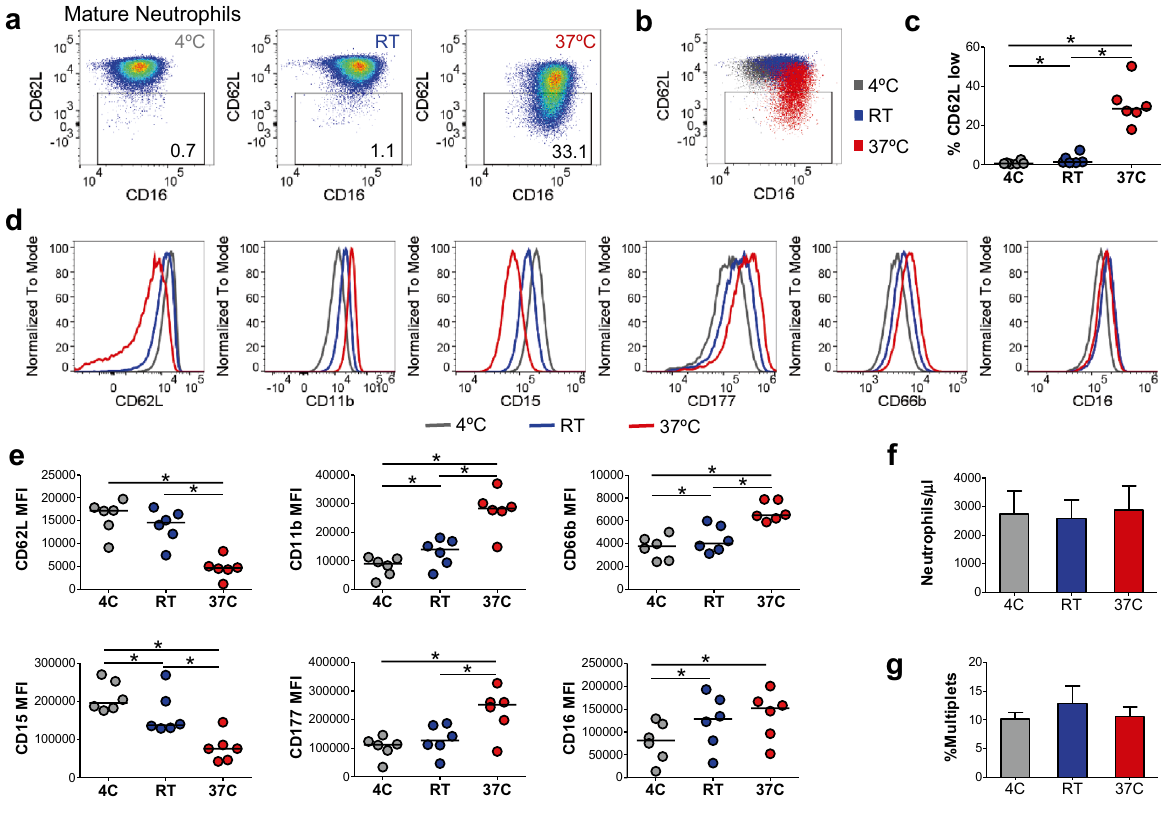
Figure 4. The effect of staining temperature on neutrophil phenotype. ( a ) Pseudocolor plots representing the staining of neutrophils from whole blood at the indicated temperatures. ( b ) Representative dot plot overlay of surface levels of CD16 and CD62L gated on neutrophils from WB incubated at the indicated temperatures. ( c ) Percentage of neutrophils with low surface levels of CD62L following staining at the indicated temperature. ( d ) Representative histogram overlays of neutrophil surface protein levels in fresh whole blood obtained from a healthy donor (HD) following staining at the indicated temperatures. CD177 histogram depicts CD177 high neutrophils only as gated in Fig. 3f. ( e ) Neutrophil surface protein levels in WB from HDs following staining at the indicated temperature. ( c , e ) Bars indicate medians *p < 0.05, ** p < 0.01, analyzed by Wilcoxon matched-pairs signed rank test. ( f ) Number of neutrophils recovered per microliter of WB and ( g ) percent of neutrophils that formed multiplets in whole blood stained at the indicated temperatures. Bars represent mean/SEM * p < 0.05, ** p < 0.01, analyzed using Wilcoxon matched-pairs signed rank test, n =